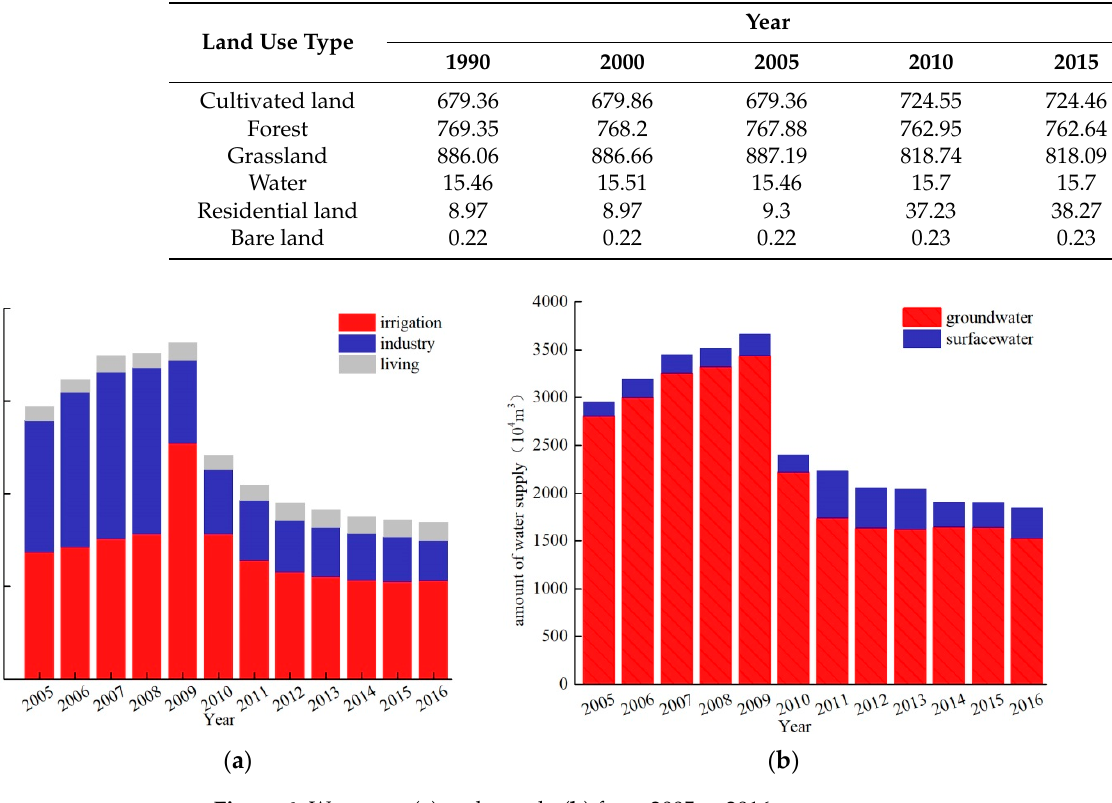
Figure 6. Water use ( a ) and supply ( b ) from 2005 to 2016.